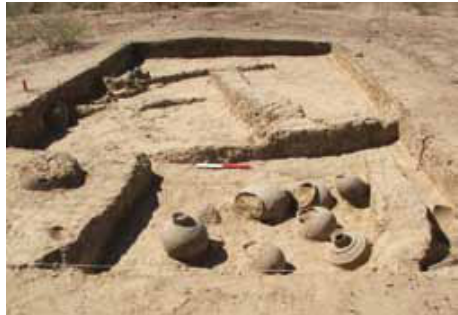
Fig. 6: Part of Unit B under excavation.